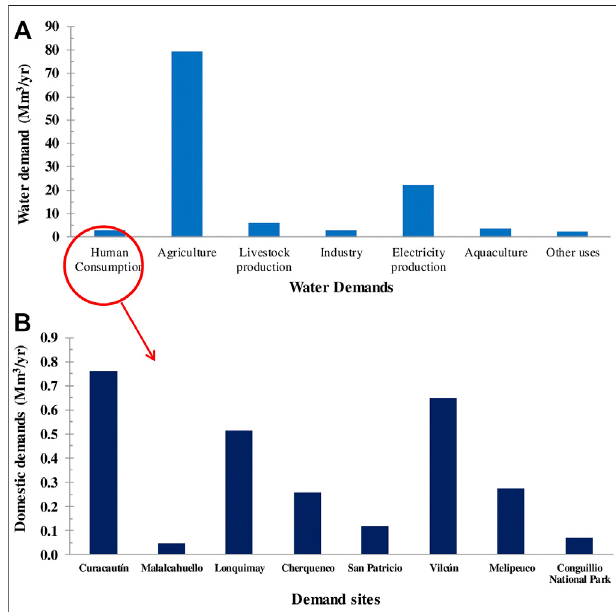
FIGURE 4 | (A) Water Demands for different uses (Mm 3 /yr). (B) Annual domestic water demand of demand sites (Mm 3